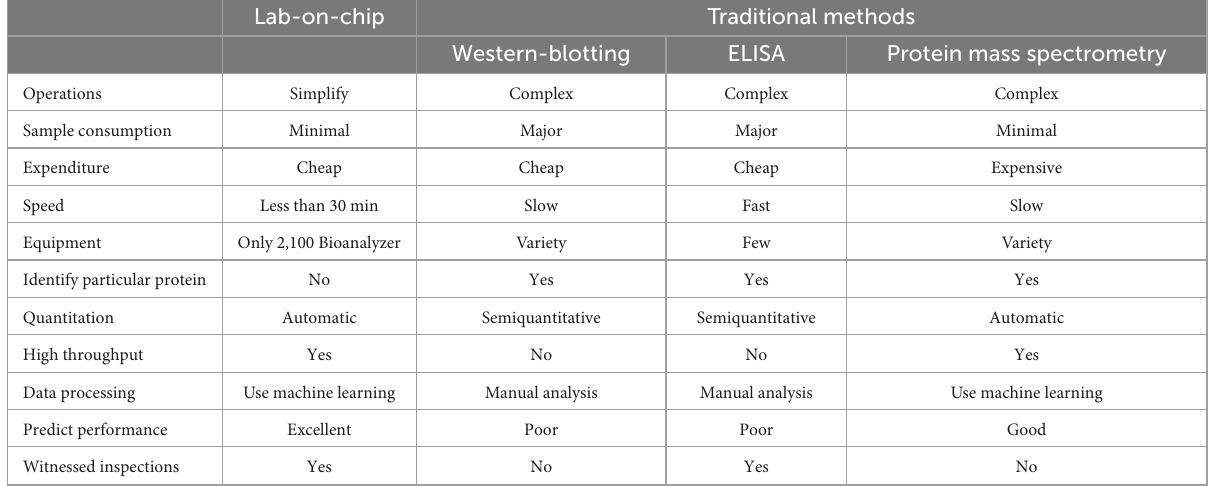
a ACCrepresentsaccuracy. b PRErepresentsprecision. c RECrepresentsrecall. TABLE 5 Comparison of lab-on-chip and traditional protein detection